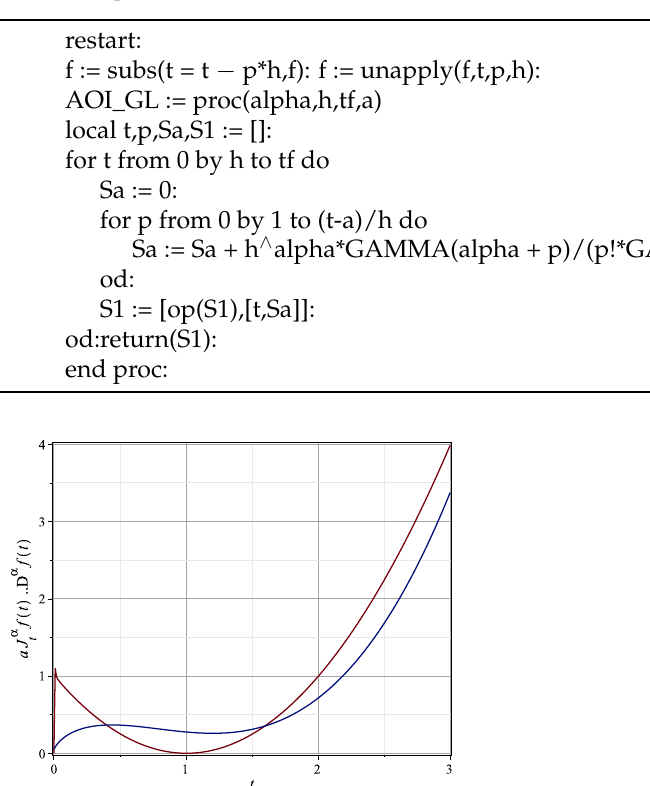
Table 3. Maple 18 code of (7).